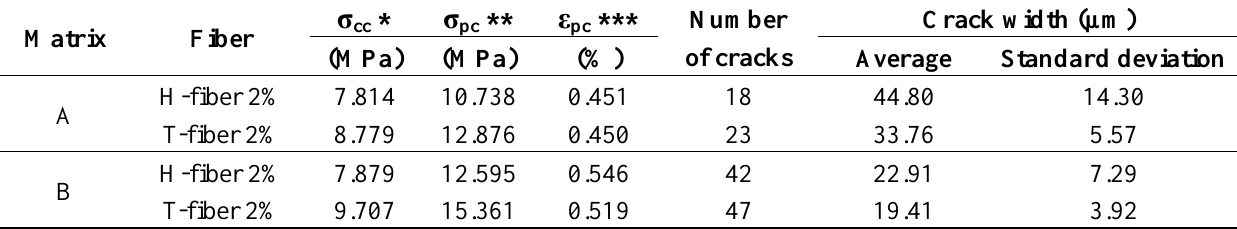
Table 3. Tensile parameters of HPFRCC according to types of fiber and